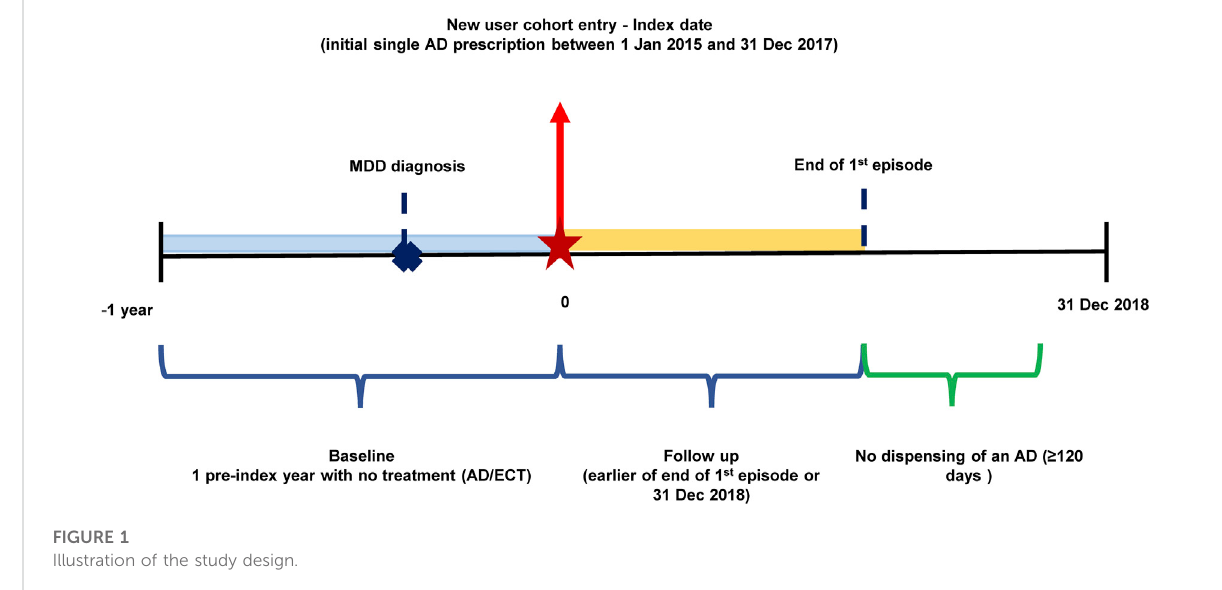
FIGURE 1 Illustration of the study design.